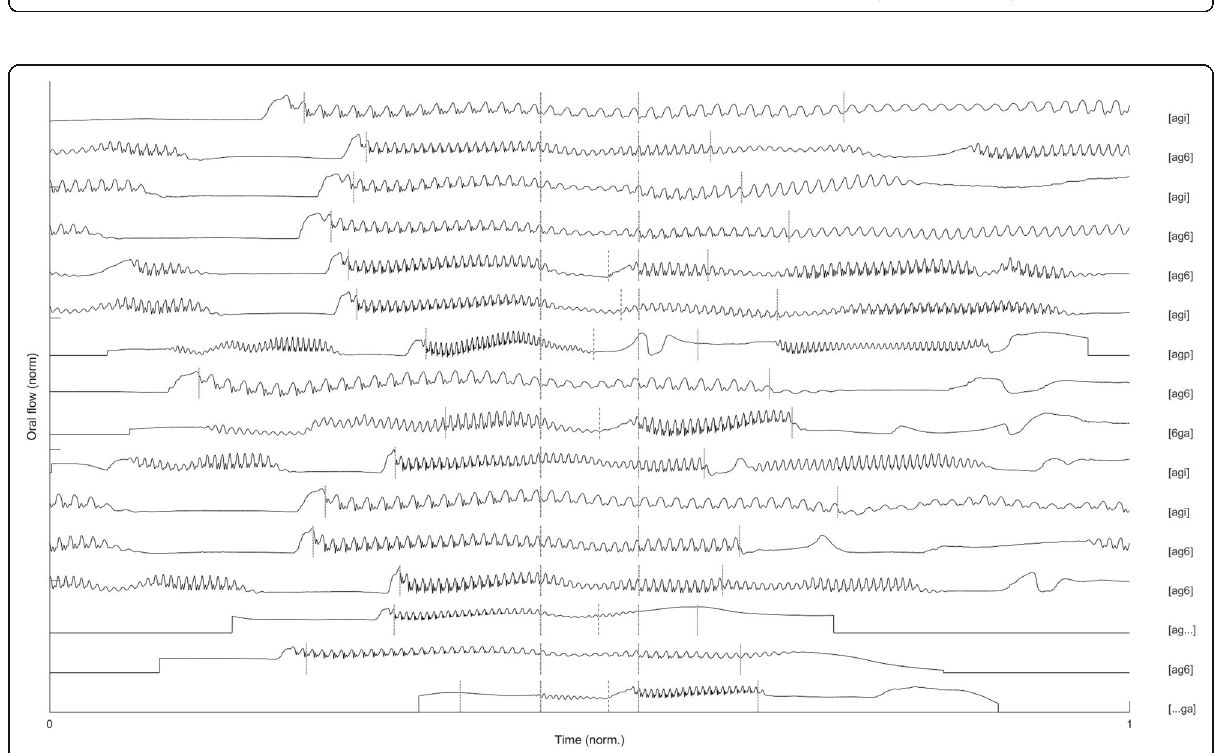
Fig. 6 Oral airflow waveforms of words with stop [d] (16 files), produced by male speaker SP1. The vertical dotted lines indicate the start of phone1 and the end of phone3. The vertical dash-dotted lines represent the phone1 – phone2 and phone2 – phone3 boundaries where phone2 is the stop. The vertical dashed lines indicate the burst when this is discernible in either the oral airflow waveform or its spectrogram. The x- and y-axes were normalised